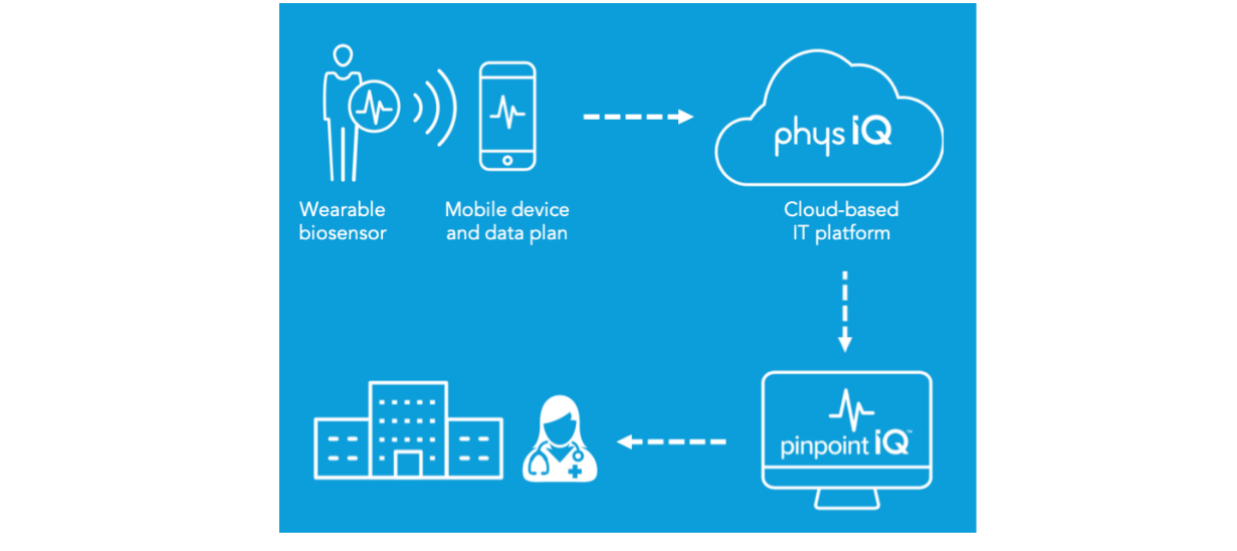
Figure 1. The accelerateIQ end-to-end solution. IT: information technology.